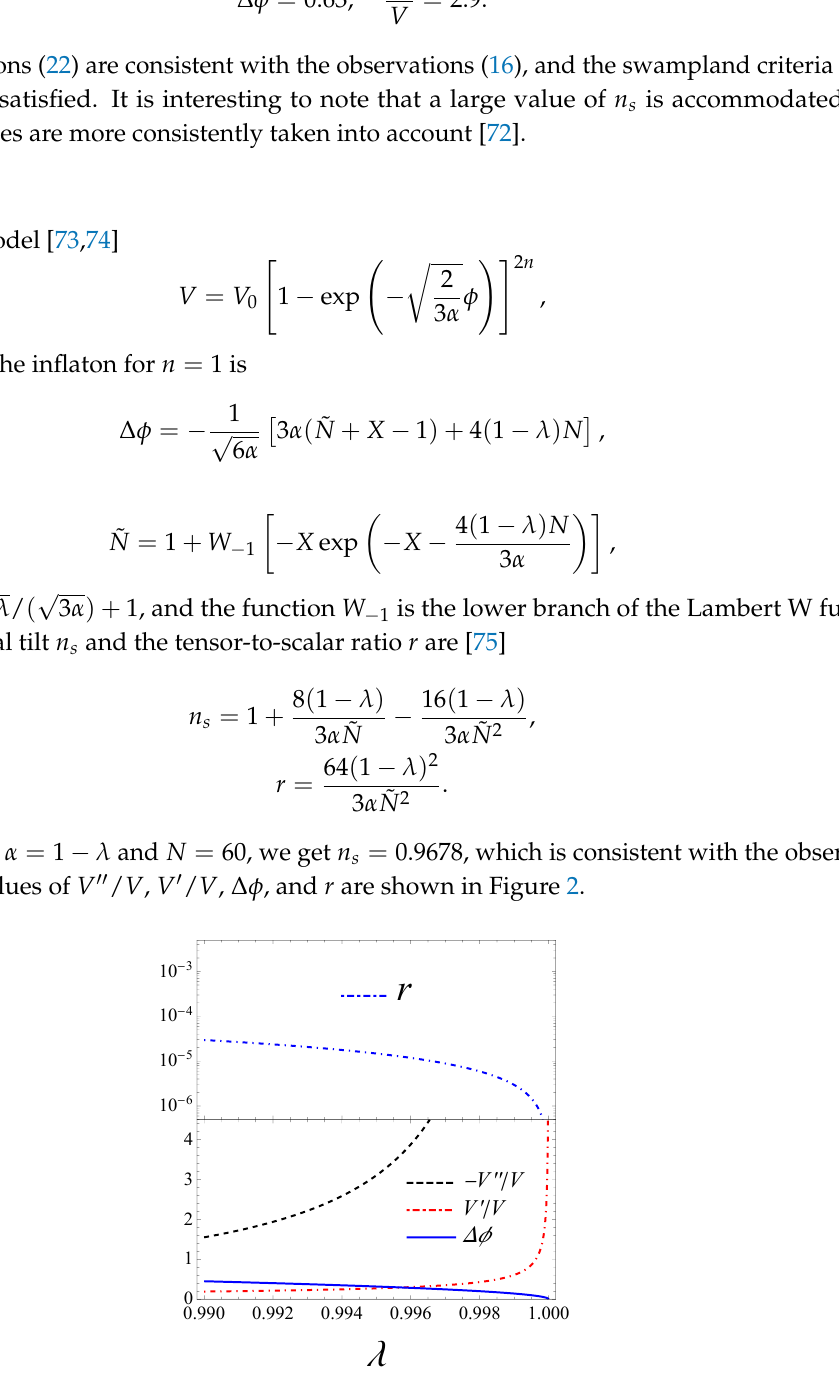
Figure 2. The dependence on λ for the the E-model with α = 1 − λ . The upper panel shows the tensor-to-scalar r . The lower panel shows the gradients of the potential V (cid:48)(cid:48) / V and V (cid:48) / V , and the field excursion ∆ φ